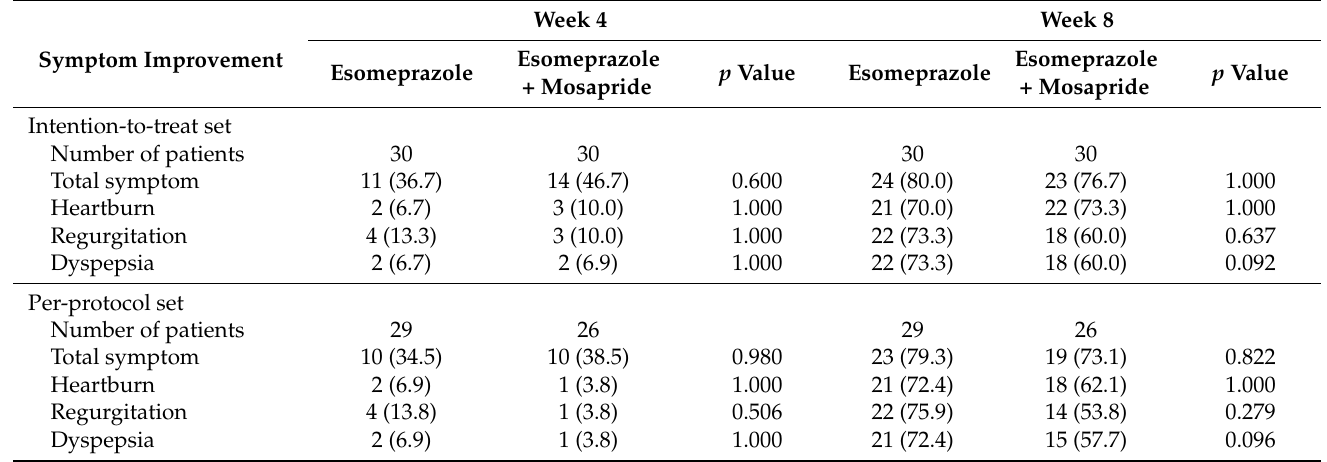
Table 3. Improvement rates of gastroesophageal reflux symptoms at four and eight